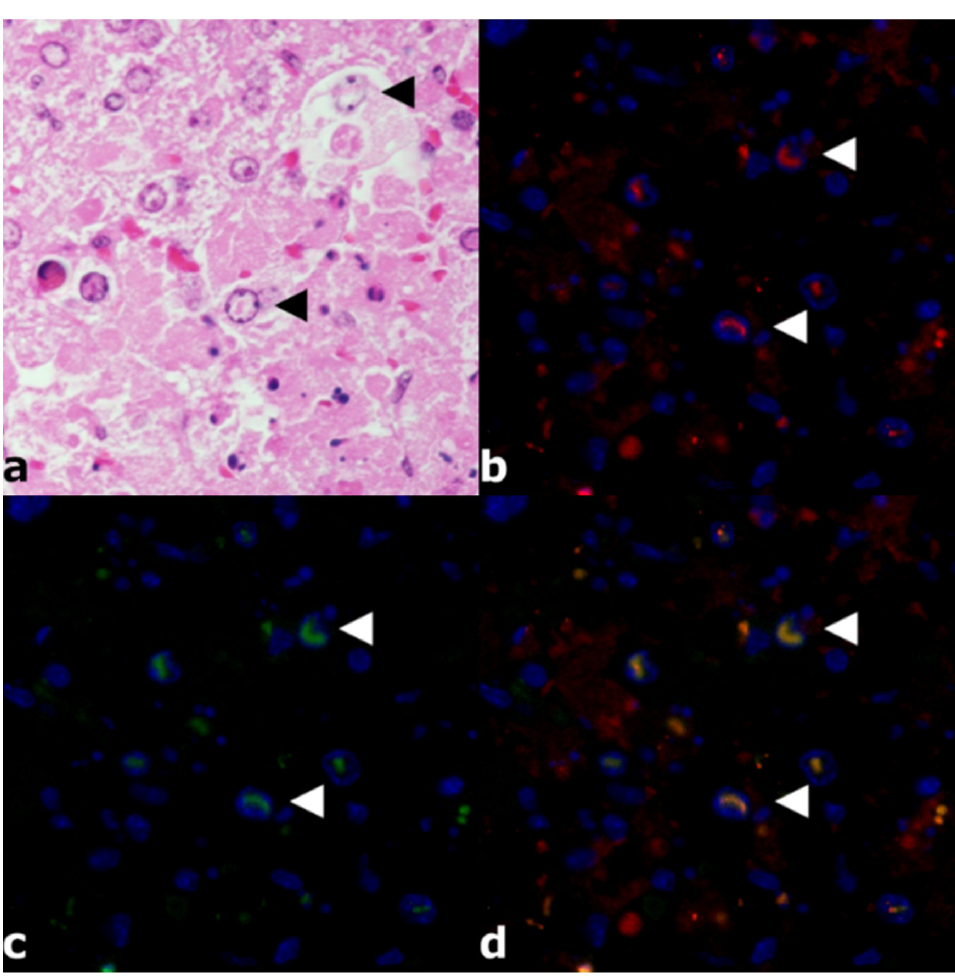
Figure 2. Immunofluorescence in liver tissue from a RVFV 35/74-infected hzNU mouse. ( a ) HE staining reveals hepatic necrosis with apoptotic hepatocytes and intranuclear, eosinophilic inclusions (arrowheads). ( b ) Immunofluorescence labels active caspase-3 (red) that accumulates in hepatocel- lular nuclei (arrowheads). ( c ) Immunofluorescence labels RVFV NSs (green) that accumulates in hepatocellular nuclei (arrowheads). ( d ) Merged image displays yellow intranuclear co-localization of RVFV NSs and active caspase-3 that matches the longitudinal, comma-shaped appearance of intranu- clear inclusions seen in the HE-stained slides (arrowheads). Abbreviations: hzNU: heterozygous Crl:NU(NCr)-Foxn1nu mice; HE: hematoxylin-eosin staining; RVFV: Rift Valley fever virus; NSs: nonstructural protein